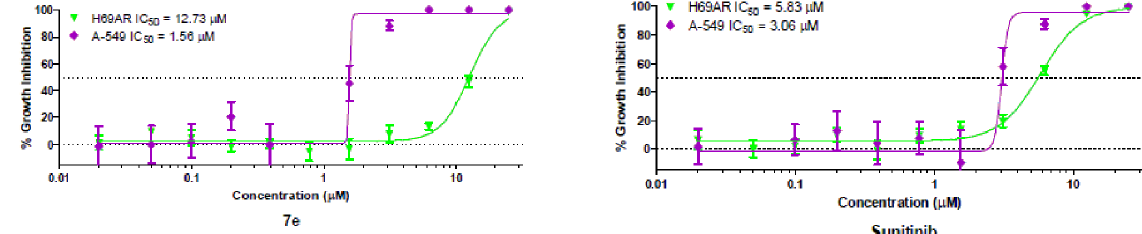
Fig 8. Tumor cell selectivity. Dose-dependent growth inhibitionby 7e or Sunitinibin a NSCLC cell line (A-549) comparedwith three non-tumorigenic cell lines: Sw-3t3 (murine fibroblasts), IEC-6 (murine inestinalepithelial cells), or MCF-10A (human mammary